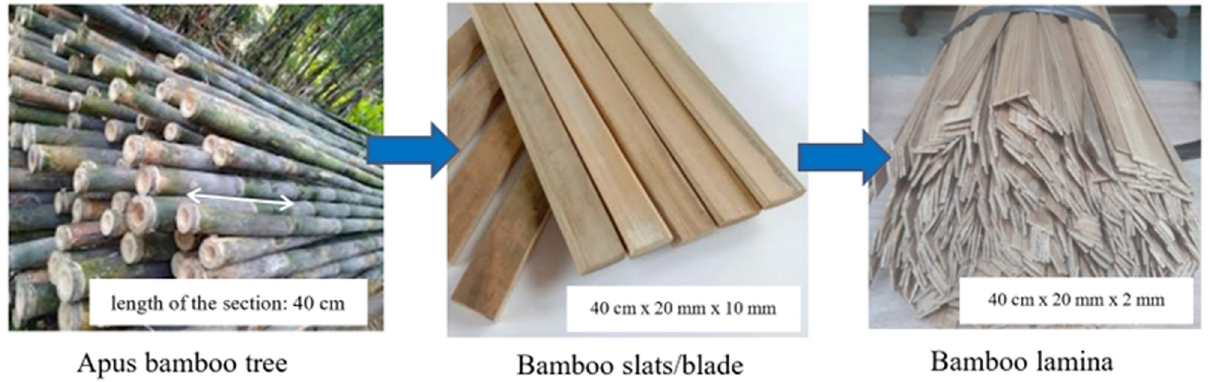
Figure 1: Bamboo lamina - making